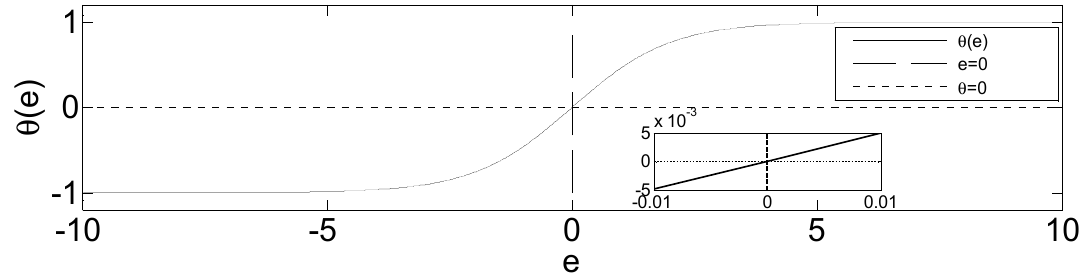
Figure 2. Graphical illustration of error transformation function.